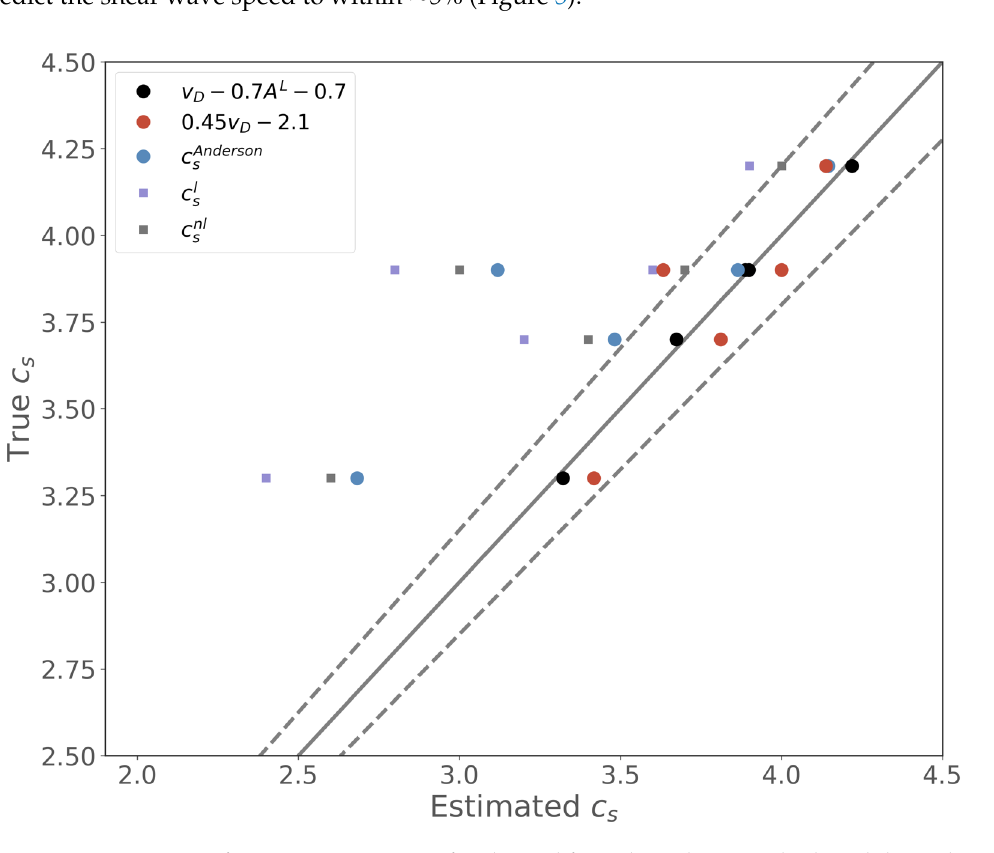
Figure 5. Comparison of c s against estimates of c s derived from the Debye speed. The solid grey line represents a one-to-one line. The dashed lines represent ± 5% of the shear speed. Points to the left of the grey line underestimate c s where as points to the right overestimate c s